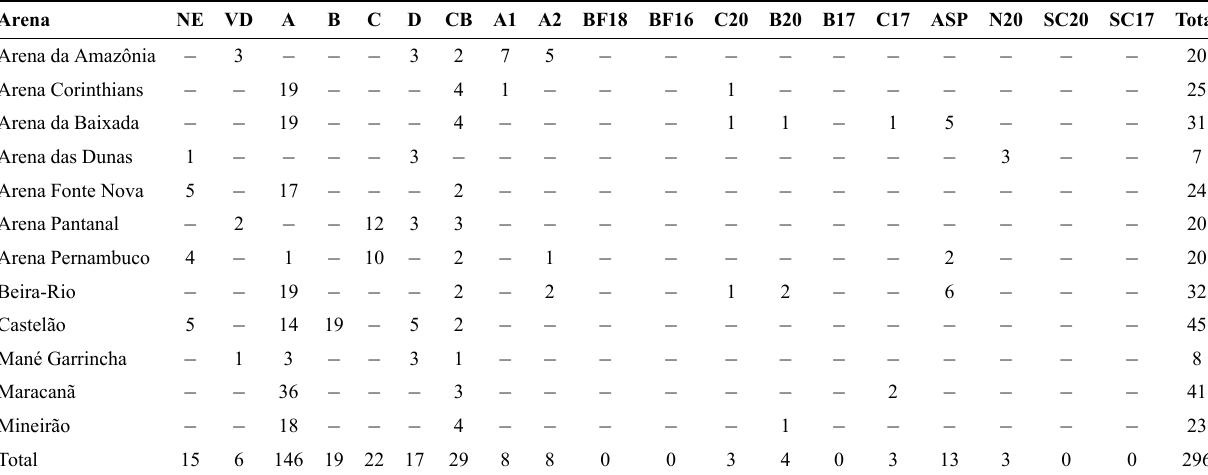
Table 6 - Arena usage in the 2018 season Arena NE